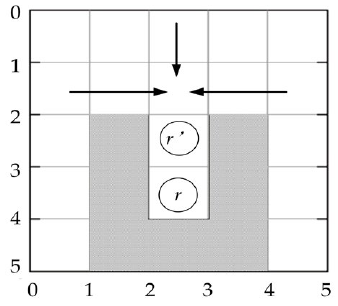
Figure 9. Raster map of U-shaped obstacles.